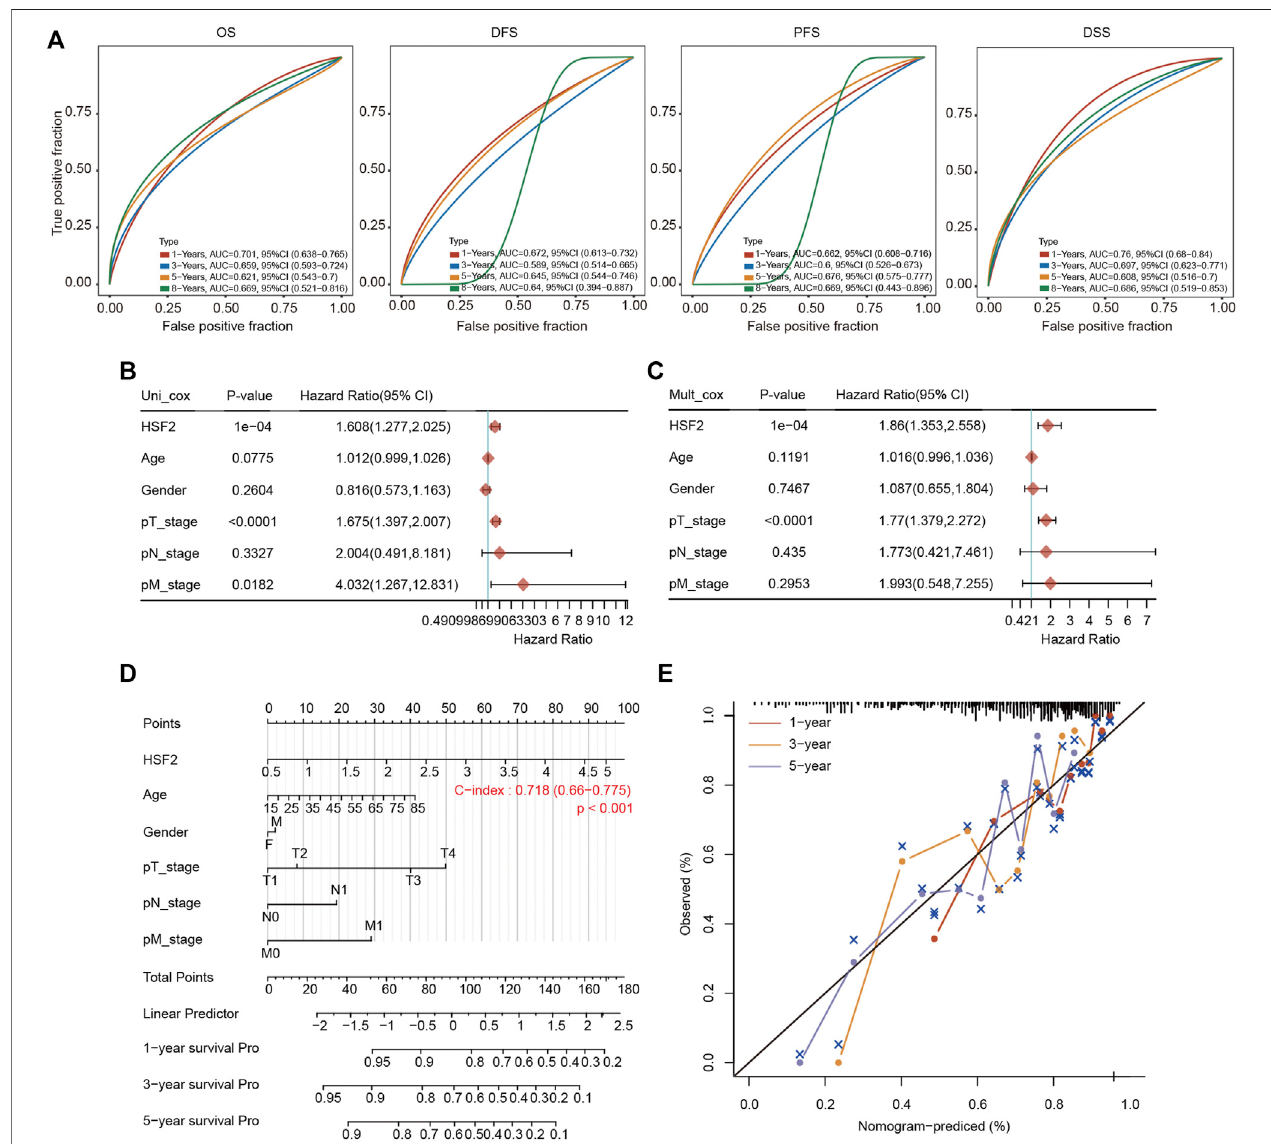
FIGURE 4 | Establishment of the prognostic nomogram. (A) ROC curves for HSF2 mRNA expression in HCC cohorts using the R software package timeROC. (B,C) Univariate and multivariate Cox regression analysis of clinicopathological variables and HSF2 expression in patients with HCC. The forests are used to show the p value, HR and 95% CI through the R package forestplot. (D) Nomogram for predicting the 1-, 3-, and 5-years OS of patients with HCC using the R software package rms. (E) Calibration curves for the 1-, 3-, and 5-years OS of patients with HCC.